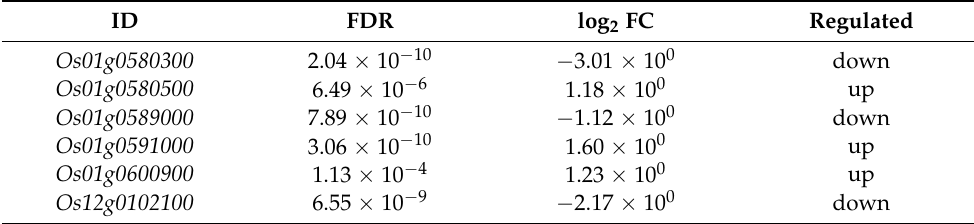
Table 6. Expression level of DEGs in the 11 enriched KEGG pathways.